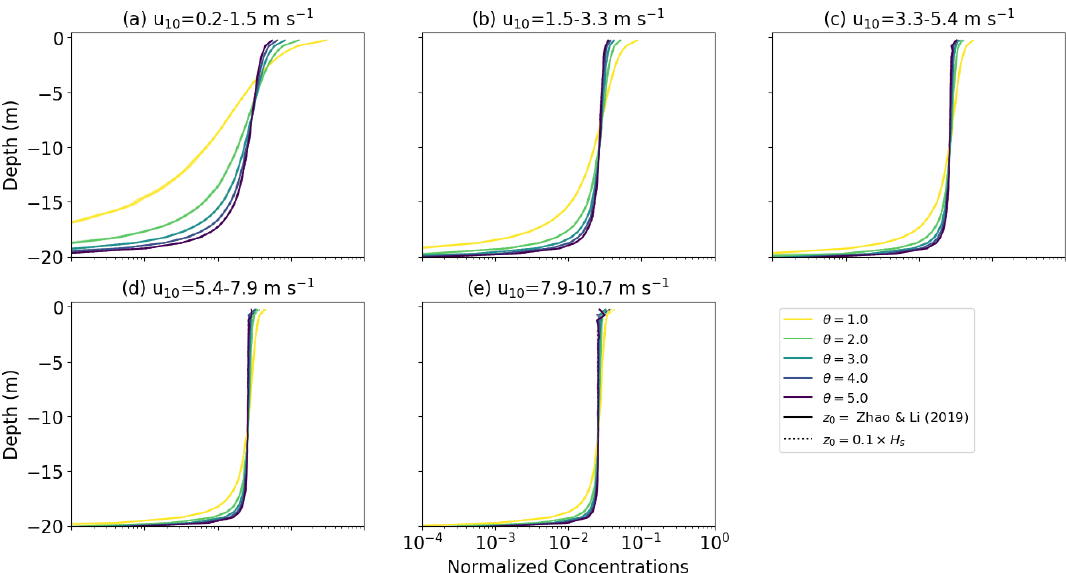
Figure D1. Vertical concentrations of buoyant particles for KPP diffusion under varying wind conditions with w r = 0 . 0003ms − 1 . The KPP diffusion profile is calculated with either z 0 according to Eq. (12) or z 0 = 0 . 1 × H s and for θ ∈ [ 1 . 0 , 2 . 0 , 3 . 0 , 4 . 0 , 5 . 0 ] . The grey markers indicate field measurements, with darker shades indicating more measurements, while the binned field measurement average and standard deviation are shown by the black markers. Shading around the profiles indicates the profile’s standard deviation at each depth level.